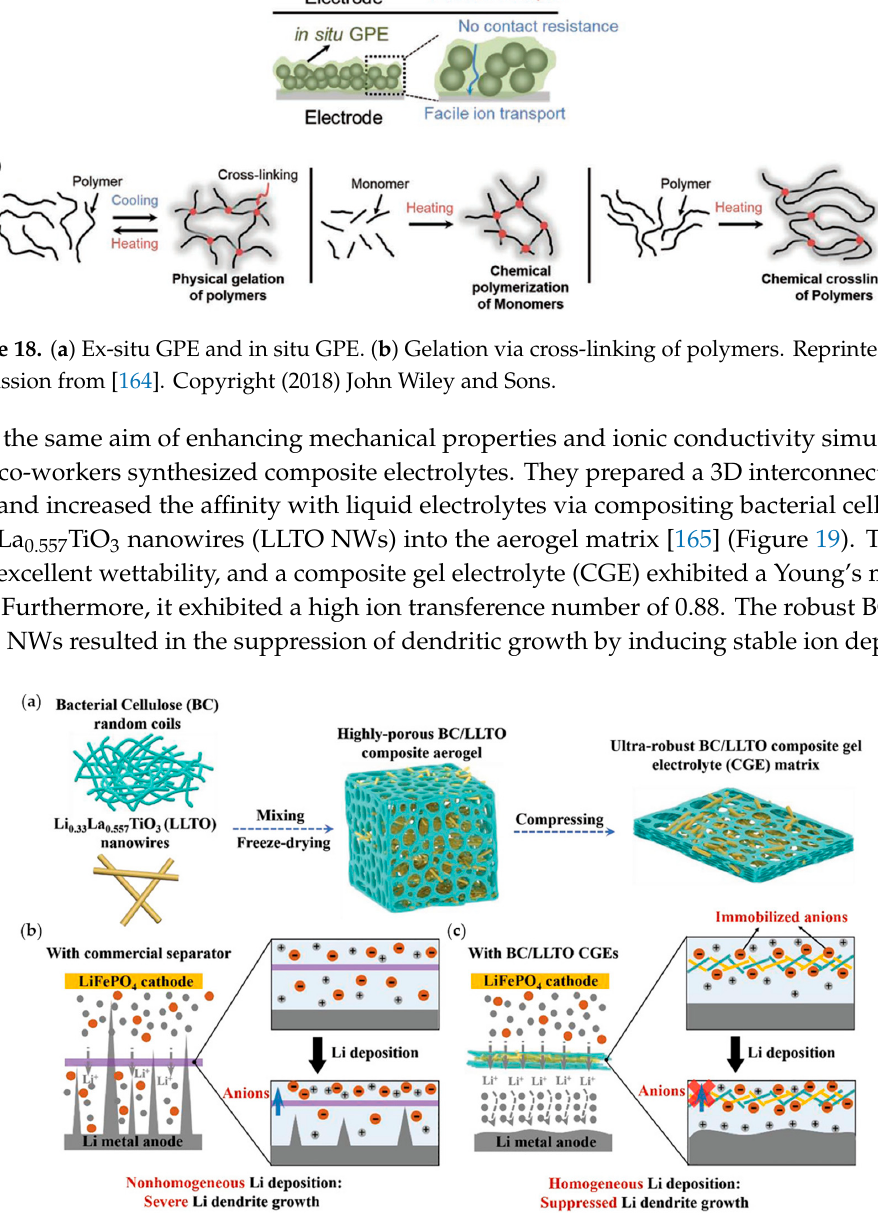
Figure 19. Preparation of BC/LLTO CGEs. ( a ) Schematic of the effect of ( b ) a commercial separator and ( c ) a BC/LLTO CGE on Li deposition in a battery. Reprinted with permission from [165]. Copyright (2019) WILEY-VCH.